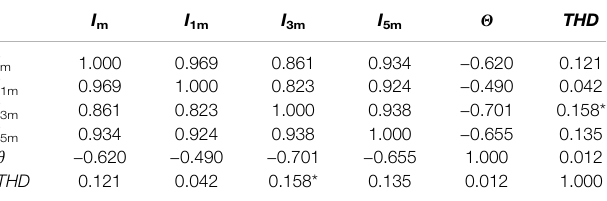
TABLE 4 | The coef fi cient of LC eigenvalues ( ESDD (cid:2) 0.2 mg/cm 2 ).